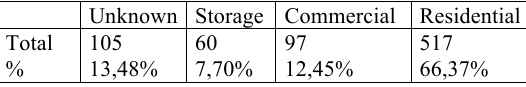
Table 3. The usage of the buildings first